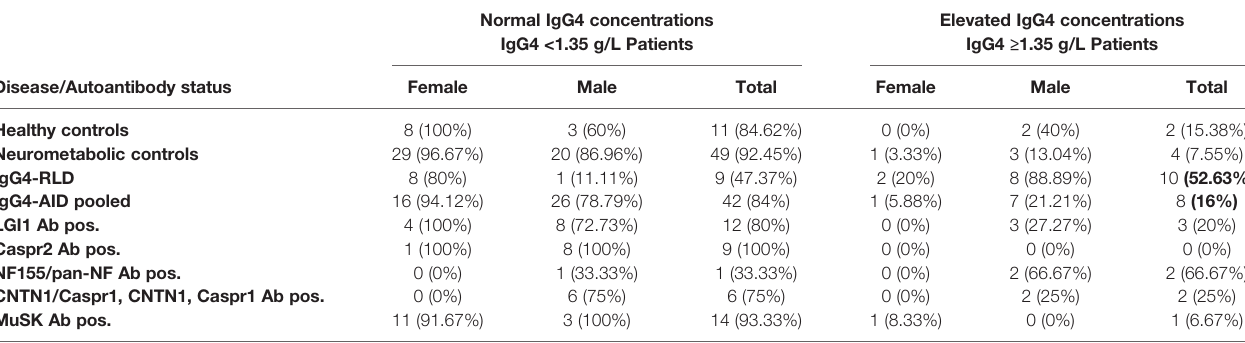
TABLE 1 | Number of patients with normal and elevated serum IgG4 concentrations in IgG4-AID and